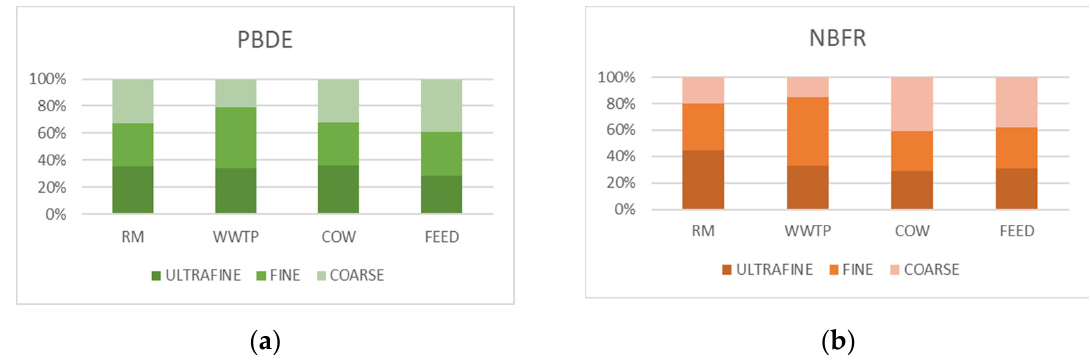
Figure 15. Percentage distribution of non-carcinogenic risk from PBDE ( a ) and NBFR ( b ) associated with ultrafine, fine and coarse fractions of PM for all the sites.